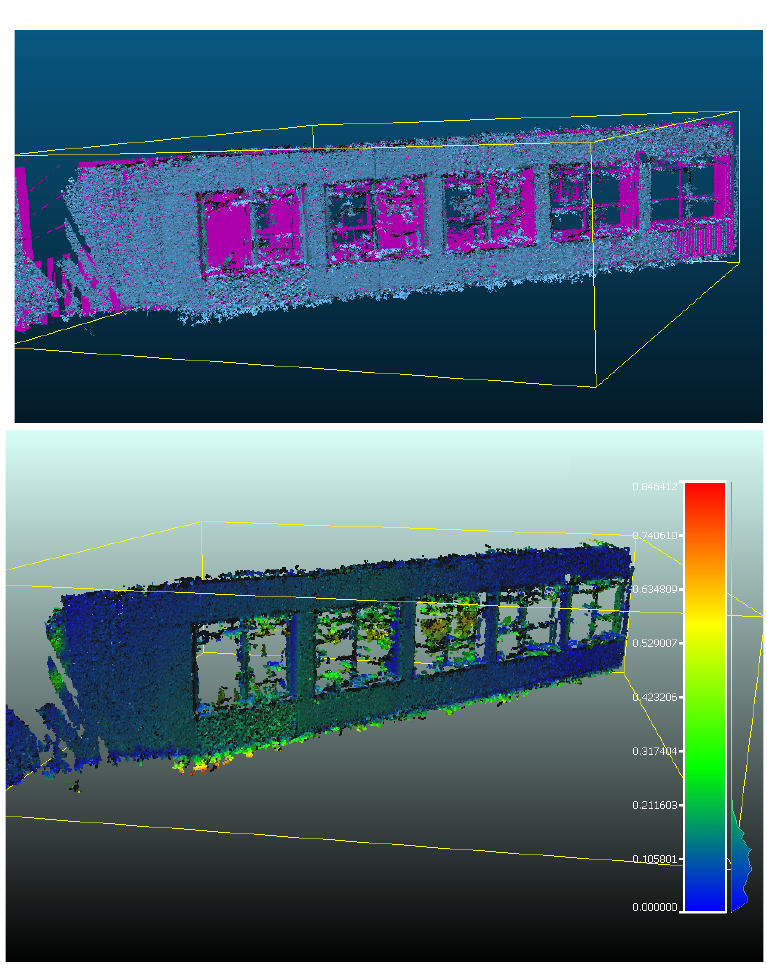
Figure 10: Top; Registered iPhone and TLS point clouds. Bottom; point to point distances are shown with pseudocoloring.